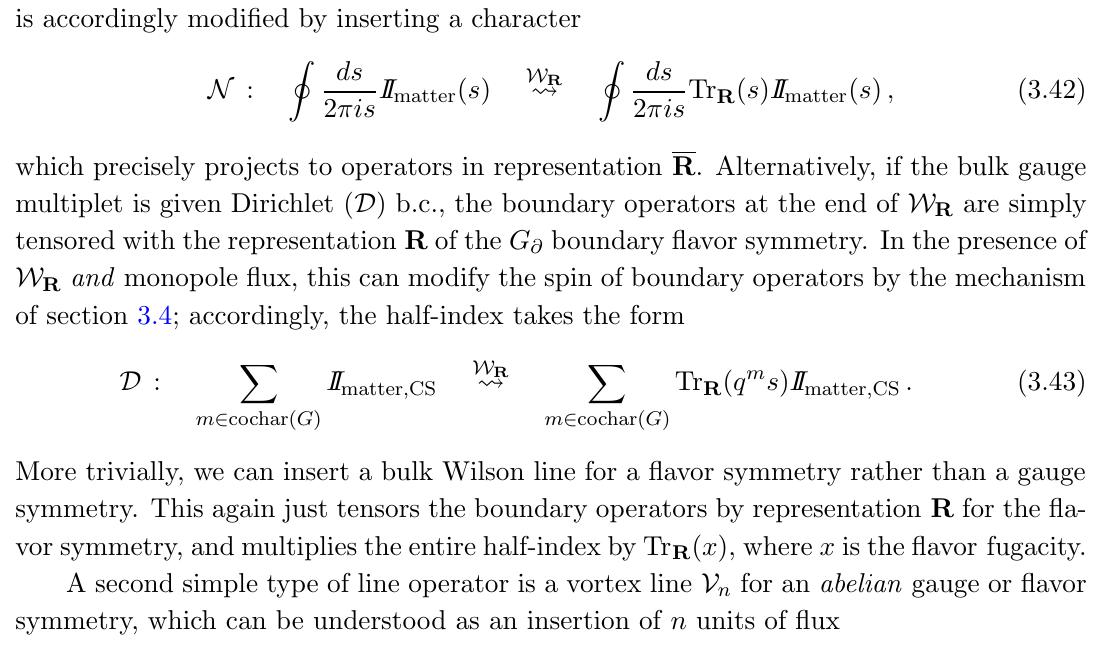
Figure 2 . Boundary local operators at the end of a line operator boundary chiral